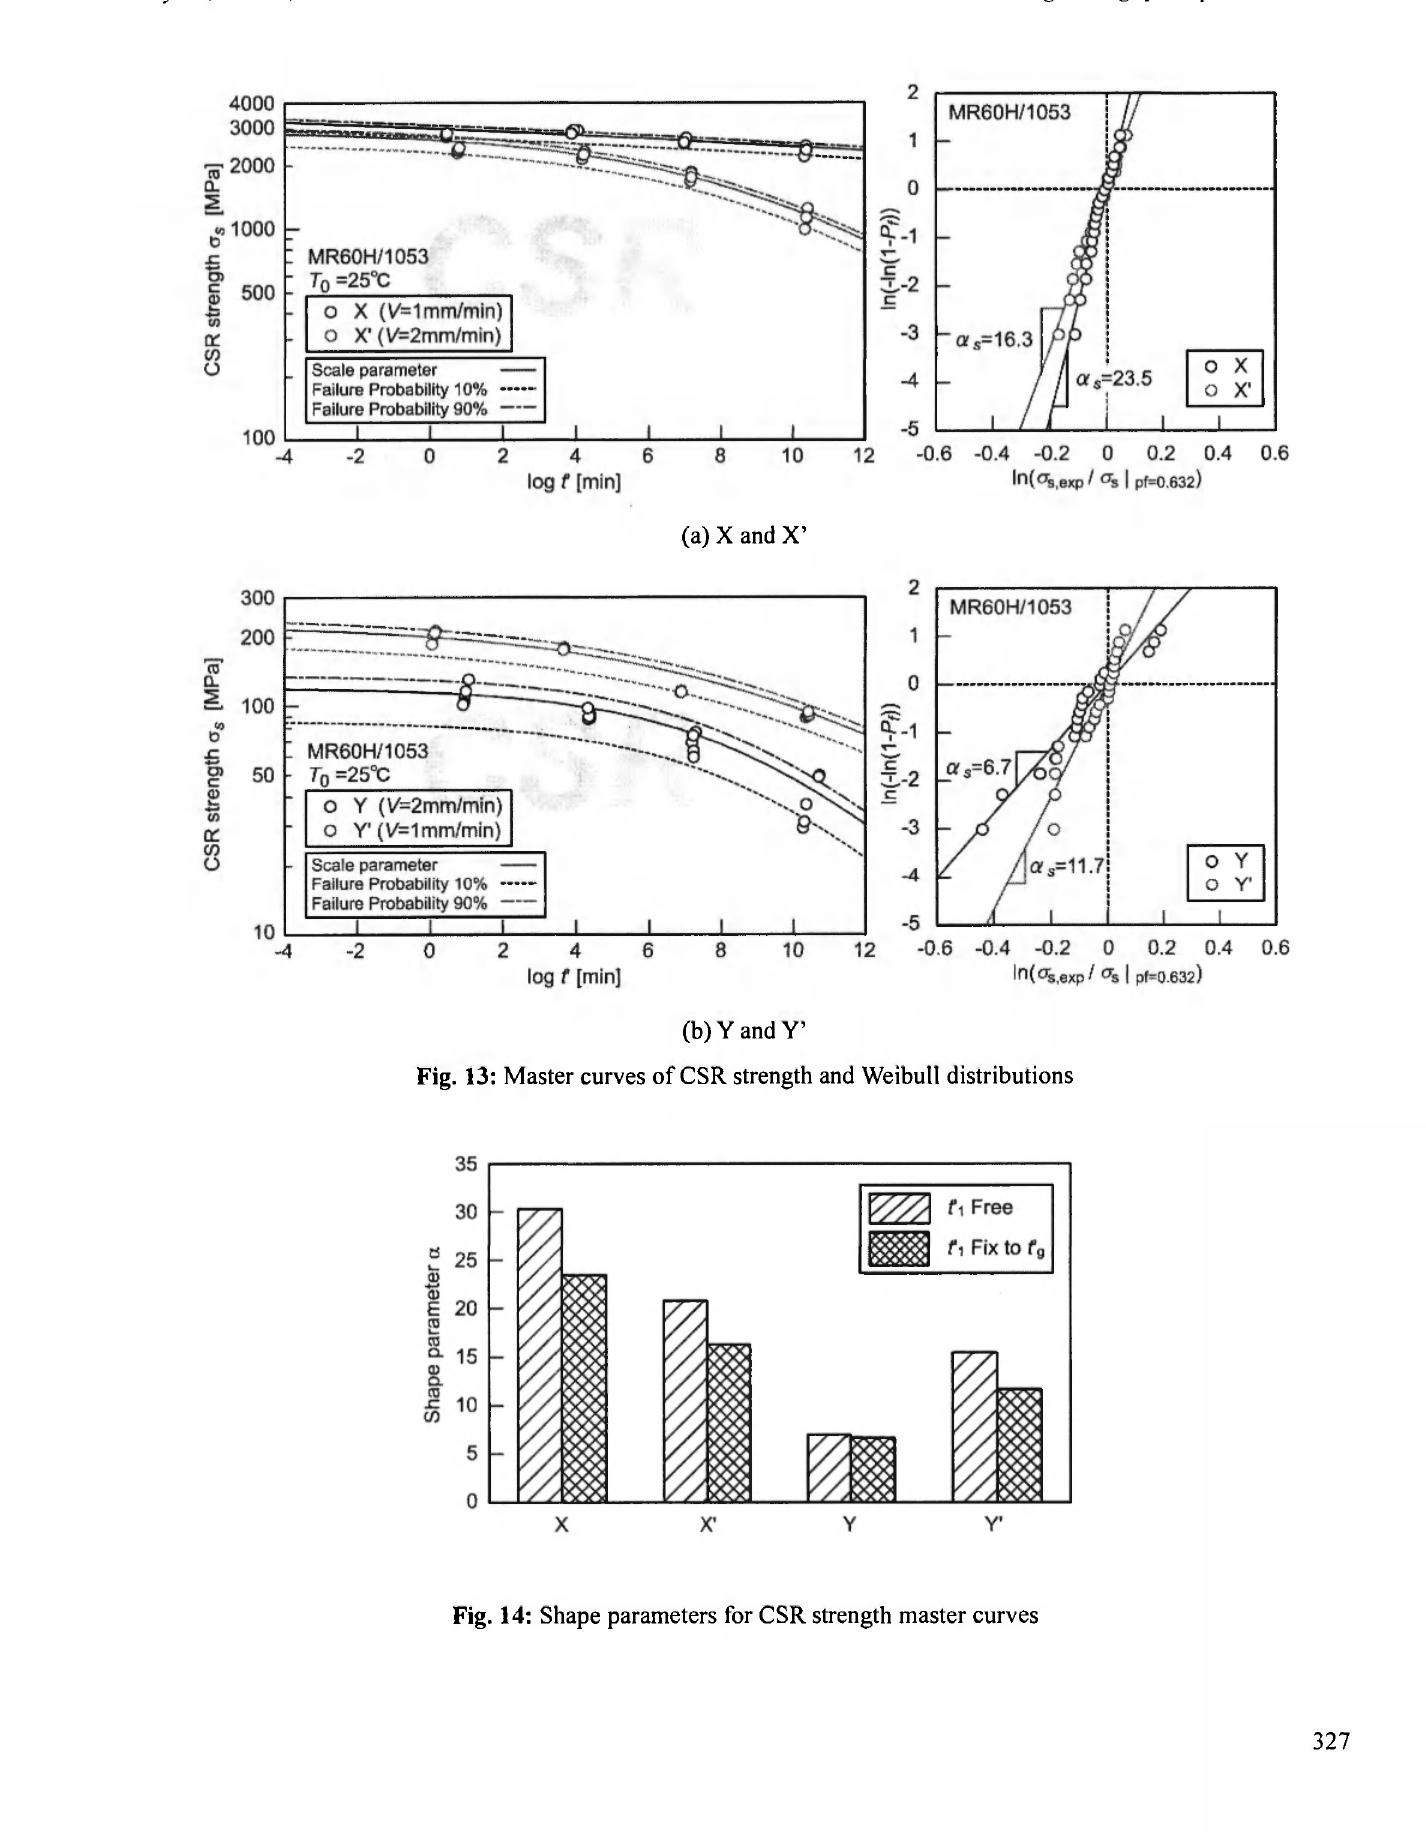
Fig. 14: Shape parameters for CSR strength master